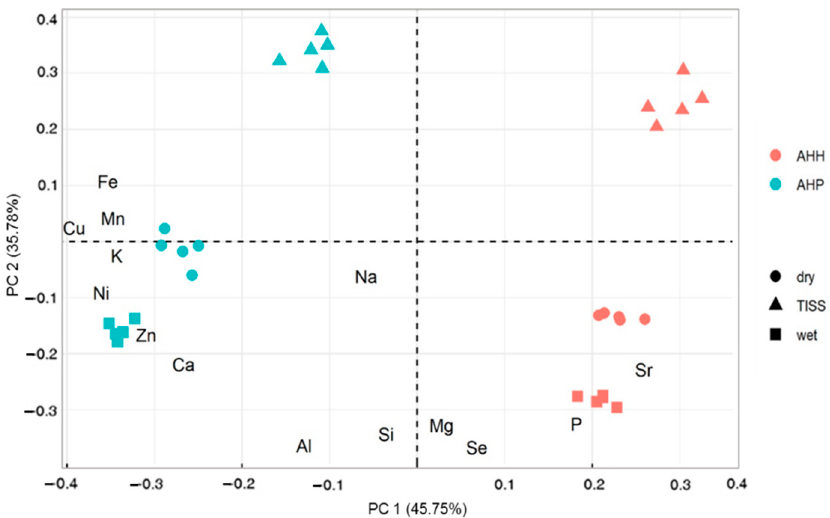
Figure 2. PCA of the whole ICP-OES data matrix: biplot of the first two PC. Light-blue symbols for AHP samples, orange symbols for AHH samples, squares for mineralized floured samples, circles for ashes, triangle for TISS fractions.